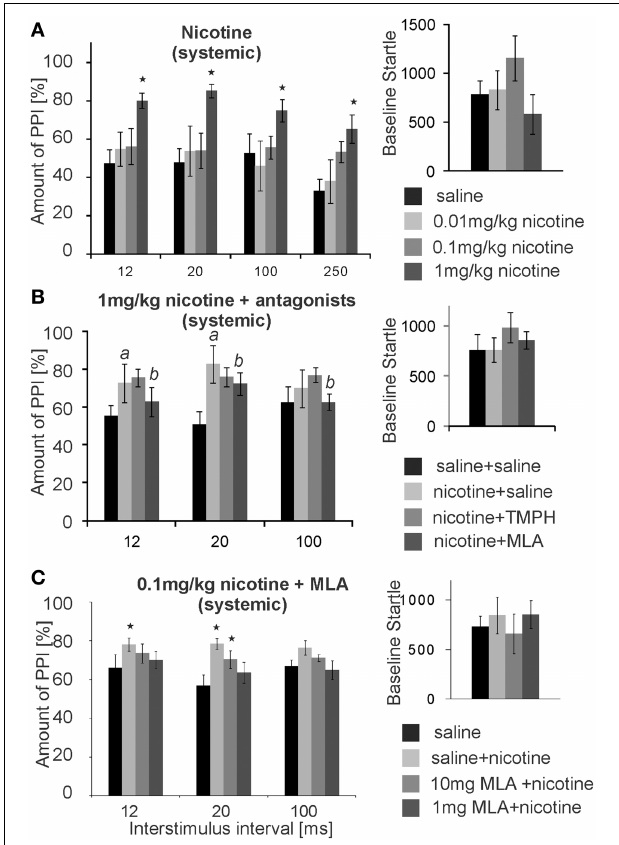
FIGURE 8 | Systemic nicotine enhances PPI, which can be reversed by systemic MLA, but not by systemic TMPH. (A) Subcutaneous injections of nicotine significantly enhanced PPI of startle at the highest dose of 1mg/kg, without changing the baseline startle amplitude ( n = 8 rats). A low prepulse of 75dB was used here. Nicotine did not significantly change baseline startle responses. (B) Another batch of rats injected with 1mg/kg nicotine also showed nicotine enhanced PPI (significant difference between saline and nicotine condition labeled by “ a ”). An additional intraperitoneal injection of 5mg/kg MLA, but not of 5mg/kg TMPH or saline, significantly reduced the nicotineenhancedPPI(significantdifferencebetweennicotineandnicotine+ MLAconditionlabeledby“ b ”).Therewasnodrugeffectonthebaselinestartle response ( n = 8 animals). (C) With a shorter protocol and only one nicotine injection per rat, subcutaneous nicotine at the dose of 0.1mg/kg significantly enhanced startle at short ISIs of 12 and 20ms. This was completely reversed by 1mg/kg MLA administered i.p., and partly reversed by 10mg/kg MLA i.p. Asterisk marks statistical significance with p < 0 . 05 ( n = 12 animals).